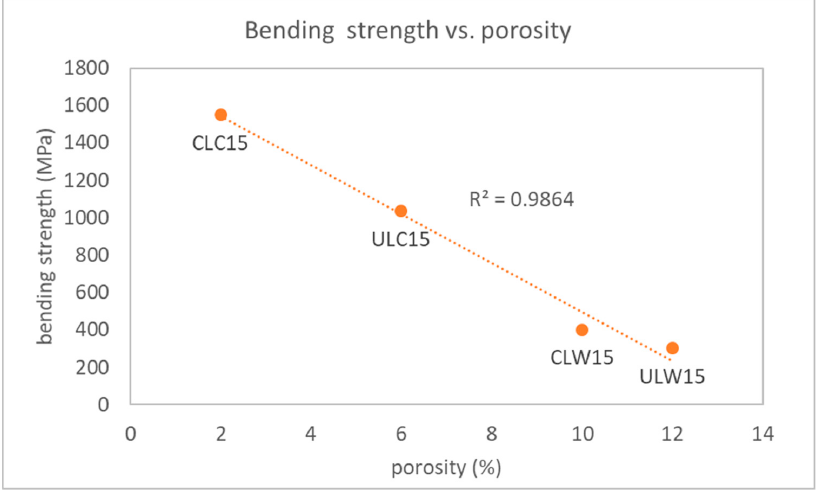
Figure 11. Correlation of bending strength and porosity for the CLC15, ULC15, CLW15 and ULW15 samples.